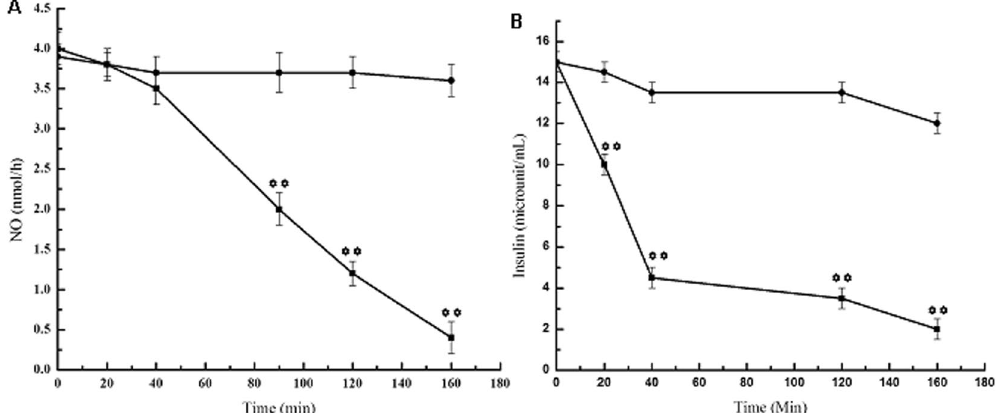
Figure 4. The in vivo effect of dermcidin on the blood glucose, NO and insulin level in normal adult mice: Purified DCN-2 was injected through tail vein into the circulation of normal mice, in the amounts similar to the plasma DCN-2 level in T1DM patients. The plasma glucose was determined by glucometer and plasma NO and insulin levels were determined by methemoglobin method and by ELISA as described in Materials and Methods at different time interval after the administration of DCN-2. Panel-A: Solid squares ( ■ ) = plasma NO level of normal mice after the treatment of DCN-2, solid circles ( ● ) = NO level in normal mice after the treatment of 0.9% NaCl. Panel-B: Solid squares ( ■ ) = plasma insulin level in normal mice after treated with DCN-2 and solid circles ( ● ) = plasma insulin level in normal mice after the treatment of 0.9% saline. The results are mean ± S.D. of at least 10 different experiments using 10 different diabetic mice ( ** represents p <